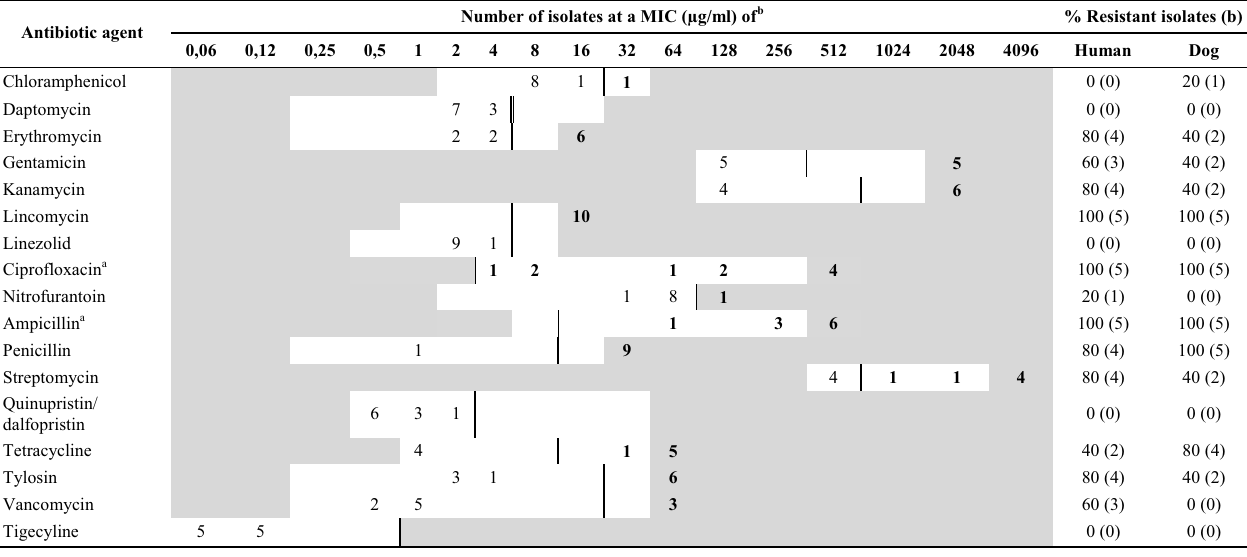
Table 3 | Antibiotic resistance of E. faecium clinical isolates from humans and dogs based on MICs. Number of isolates at a MIC (µg/ml) of b % Resistant isolates Antibiotic agent